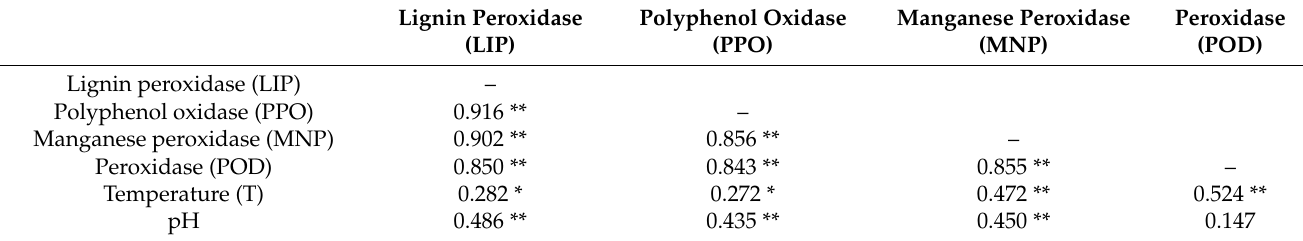
Table 4. The correlation analysis of enzyme with temperature, pH and enzyme activity. Lignin Peroxidase Polyphenol Oxidase Manganese (LIP) (PPO)